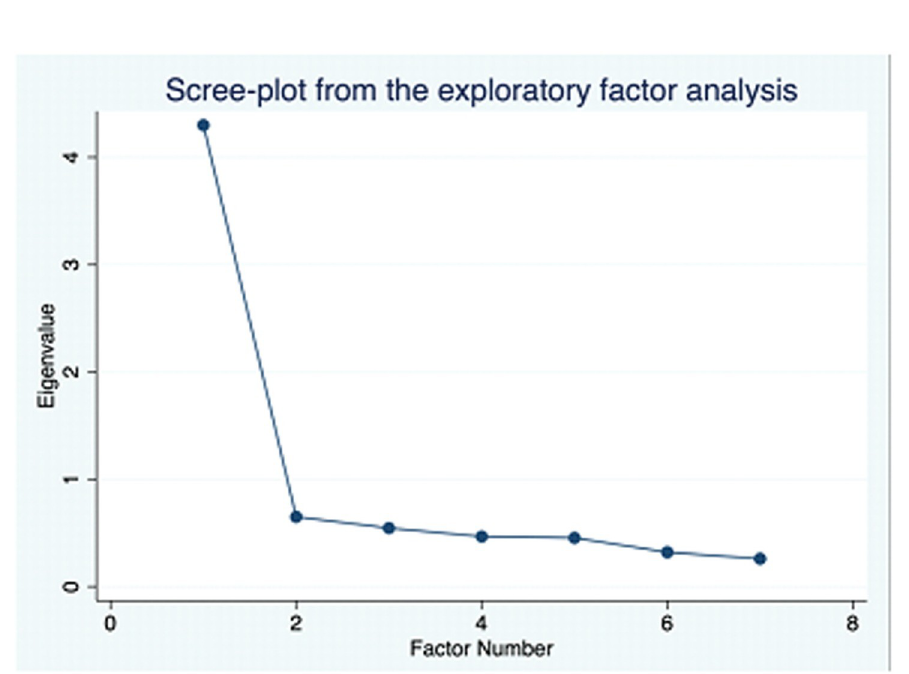
Fig 1. Scree-plot of